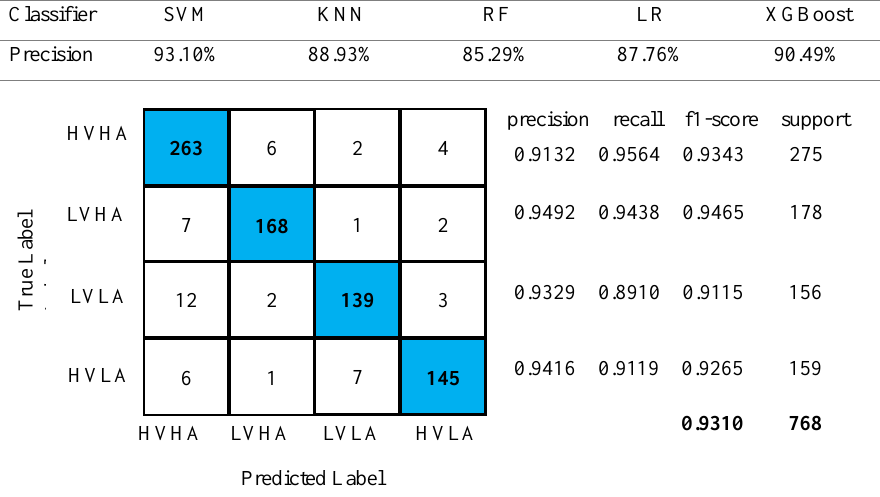
Fig. 4. Specific classification performance of 1D-CNN-SVM emotion recognition